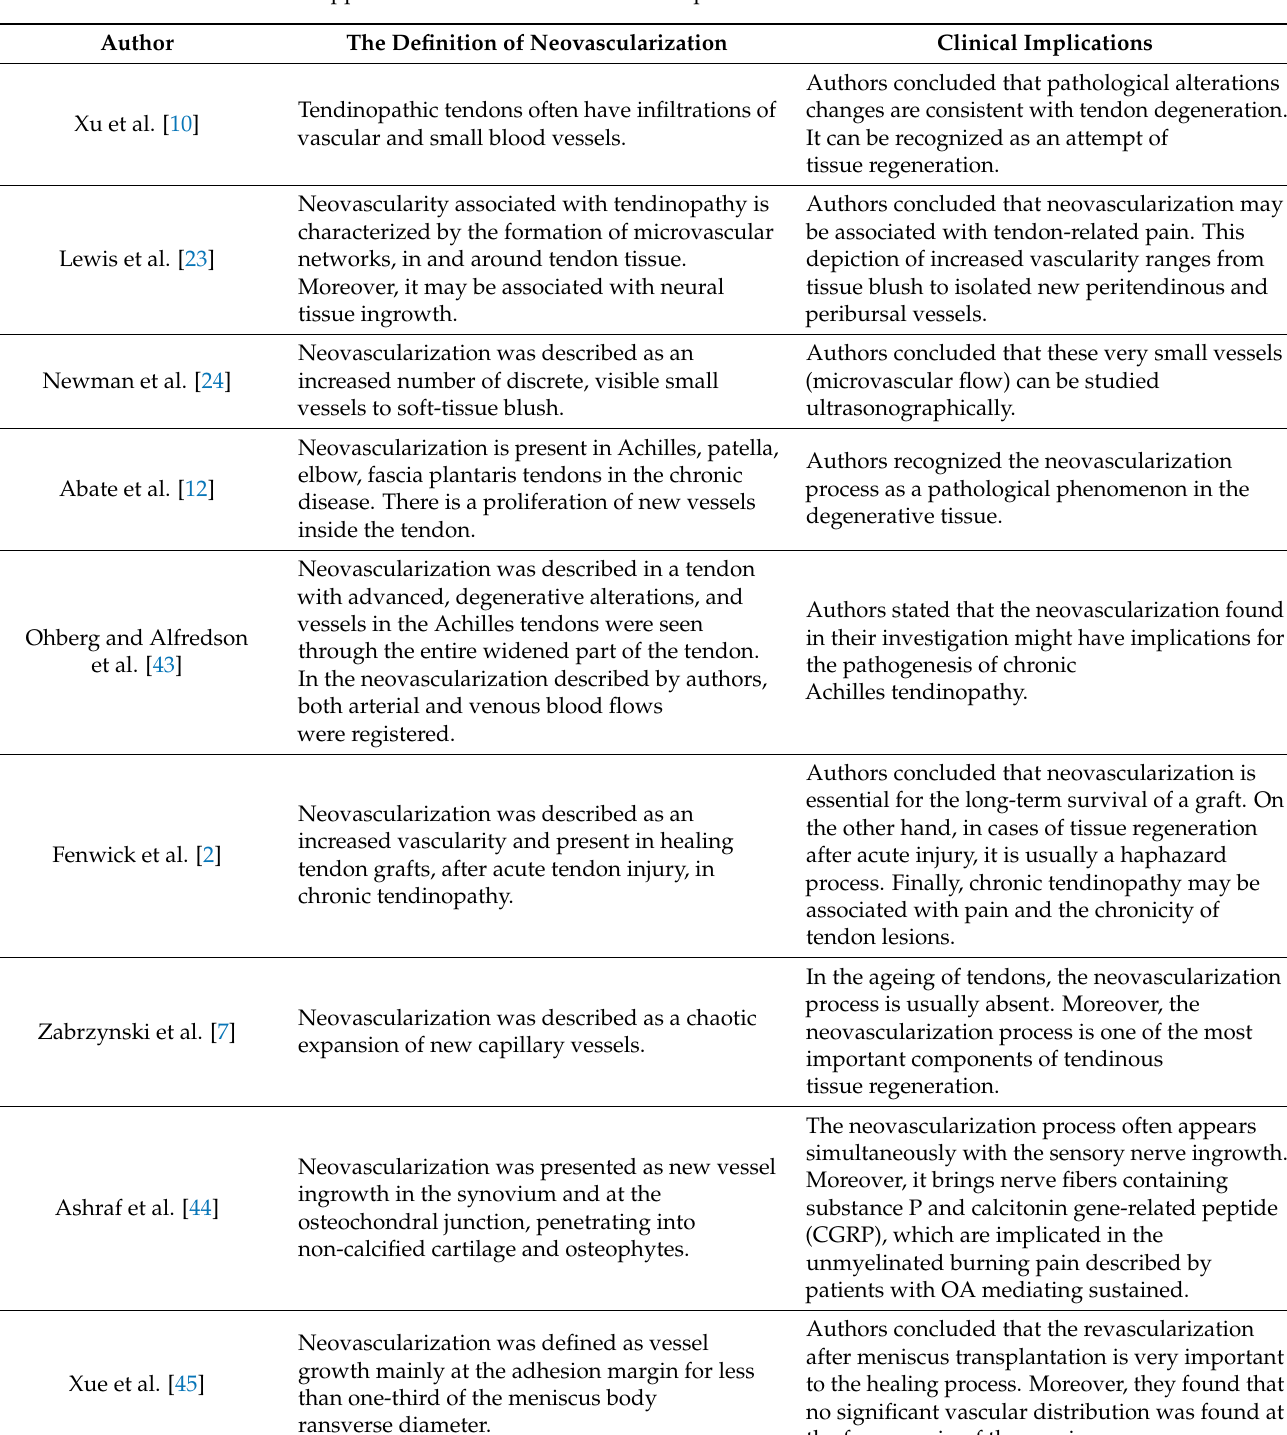
Table 1. Different approaches to the neovascularization phenomenon in tendon and meniscus